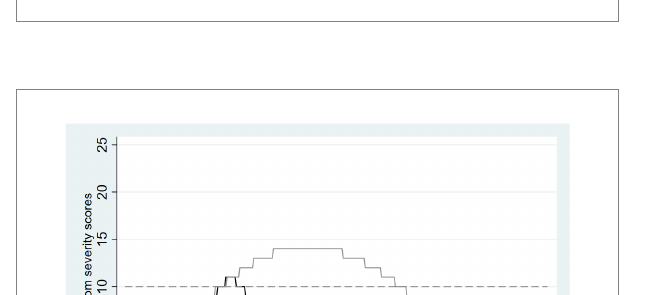
FIGURE 3 Hypothetical pattern of symptom severity over one year, depicting a potential divergence of DSM-5 and ICD-11 categorization.